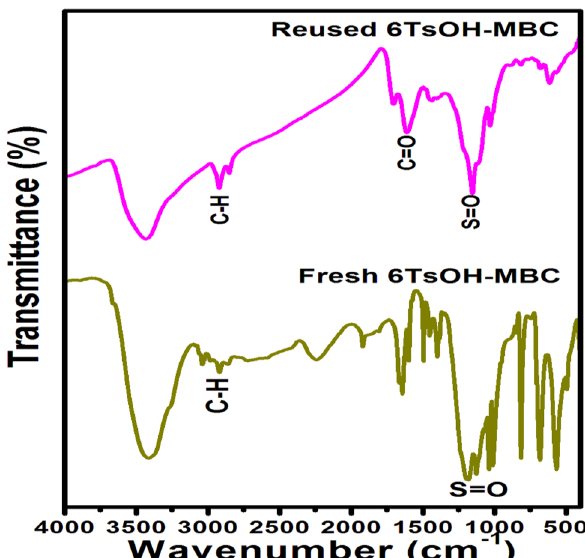
Figure 9. FTIR spectra of fresh and reused 6TsOH-MBC